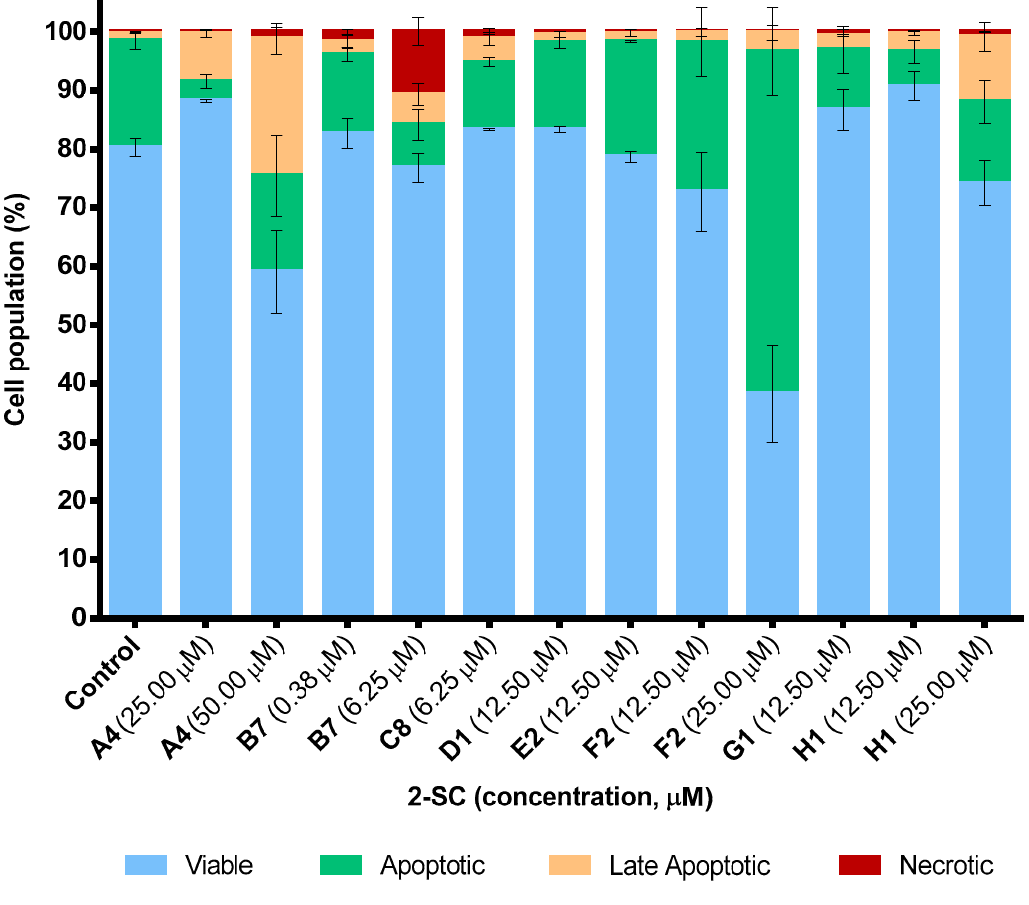
Figure 5. Representative examples of the effect of 2-SC on neutrophils’ viability, for different concentrations: A4 (25.00 and 50.00 µ M), B7 (0.38 and 6.25 µ M), C8 (6.25 µ M), D1 (12.50 µ M), E2 (12.50 µ